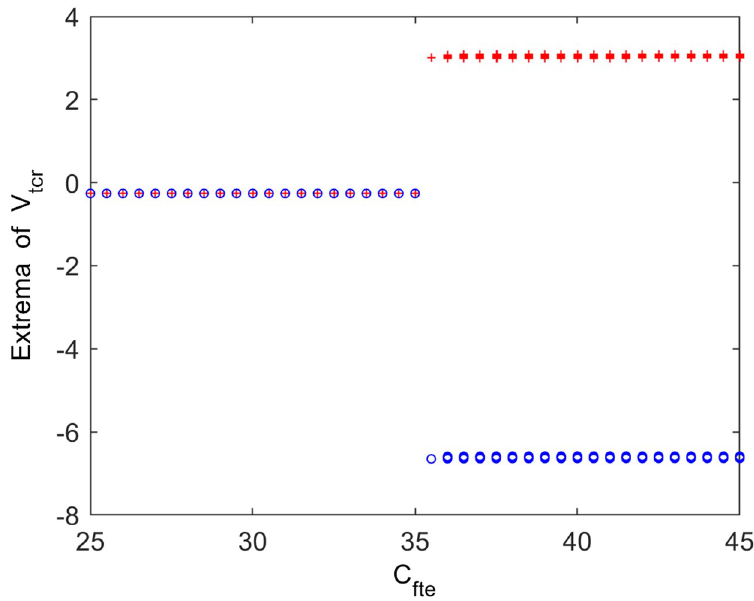
Fig 3. Bifurcation diagram of the thalamic module output’s extrema for varying values of connectivity parameter C fte . Red and blue points represent the local maximum and minimum of the thalamic module output, respectively.